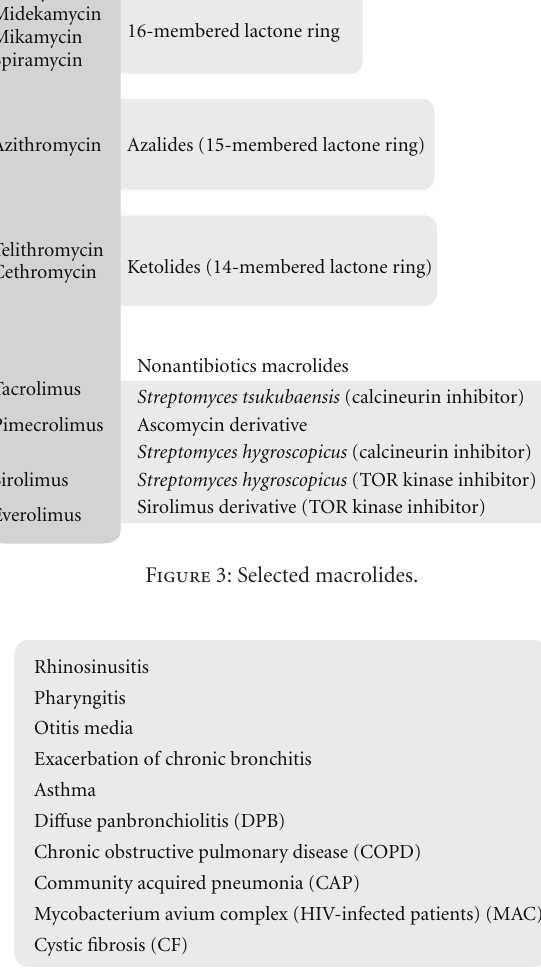
FKBP (FK506-binding protein).